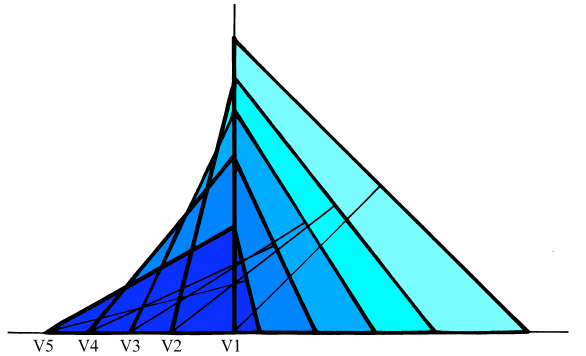
Fig. 6. Efficient shape of fillet-penetrated weld